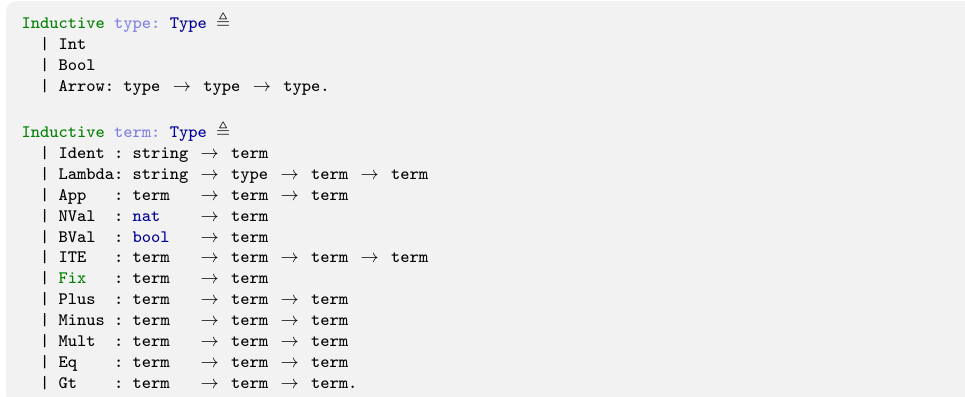
Figure 3. Type-extended Lambda